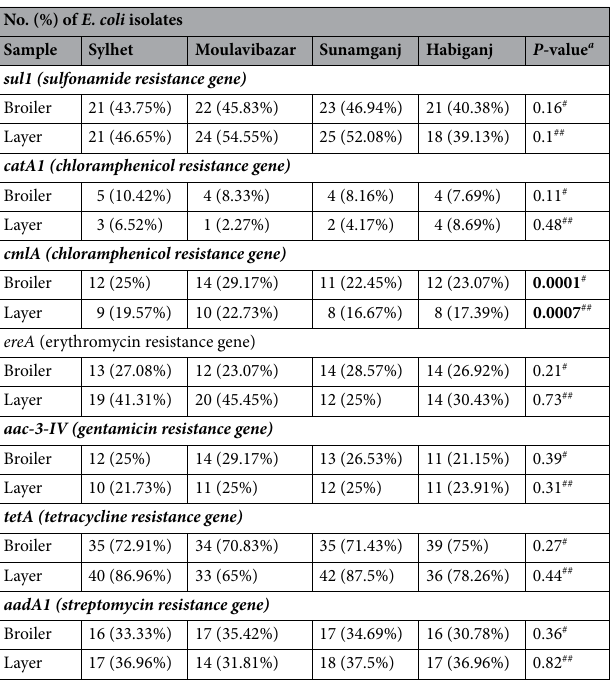
Table 5. Prevalence and distribution of non-beta-lactam ARGs among the investigated E. coli ( n = 381) isolates in relation to the four districts of Sylhet division under study. a P values were calculated using a two- way analysis of variance (ANOVA) without replication. P values < 0.05 are highlighted in bold. # Variance between broiler and layer chickens. ## Variance among the four districts under